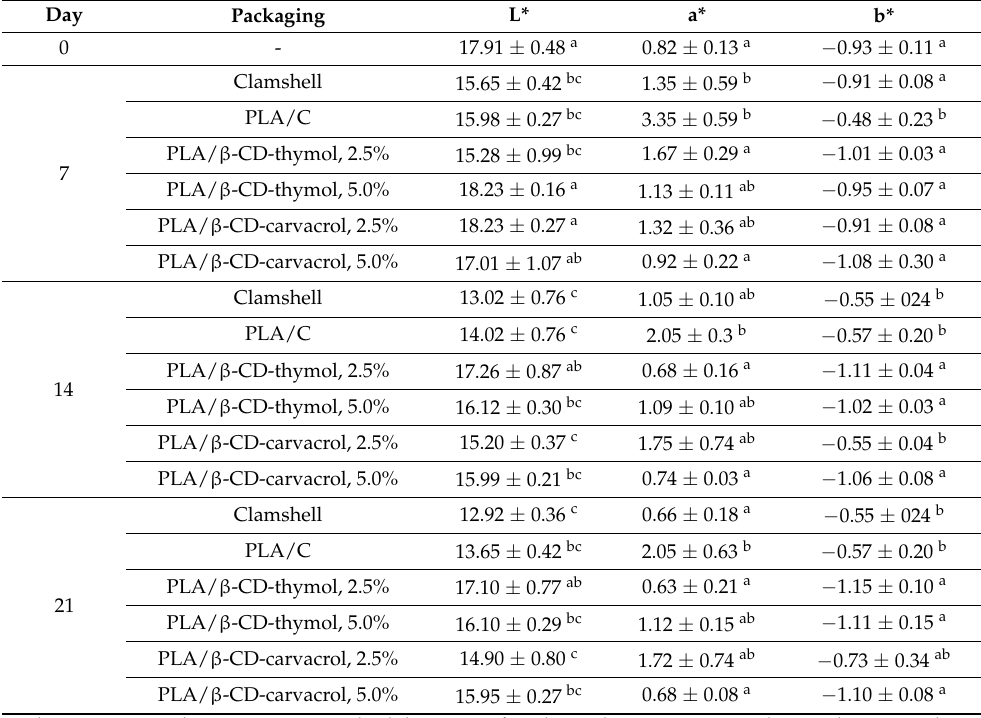
Table 1. Changes in color parameters (L*, a*, b*) of blackberries under different packaging at 0, 7, 14, and 21 days of storage at 4 ◦ C.